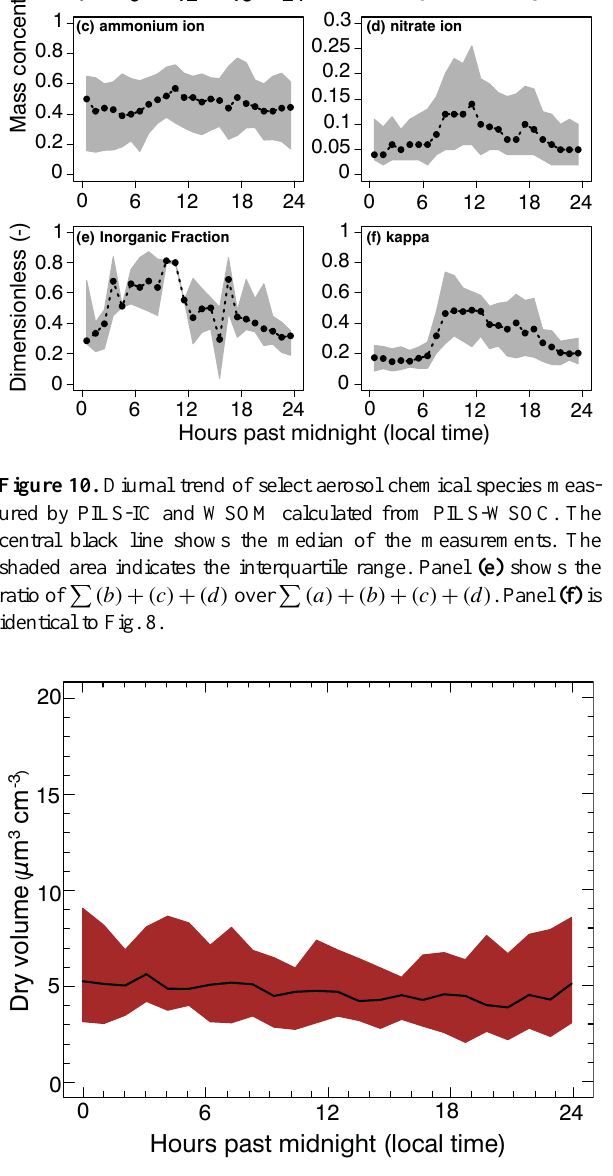
liquid water (dry aerosol volume, hygroscopicity, and